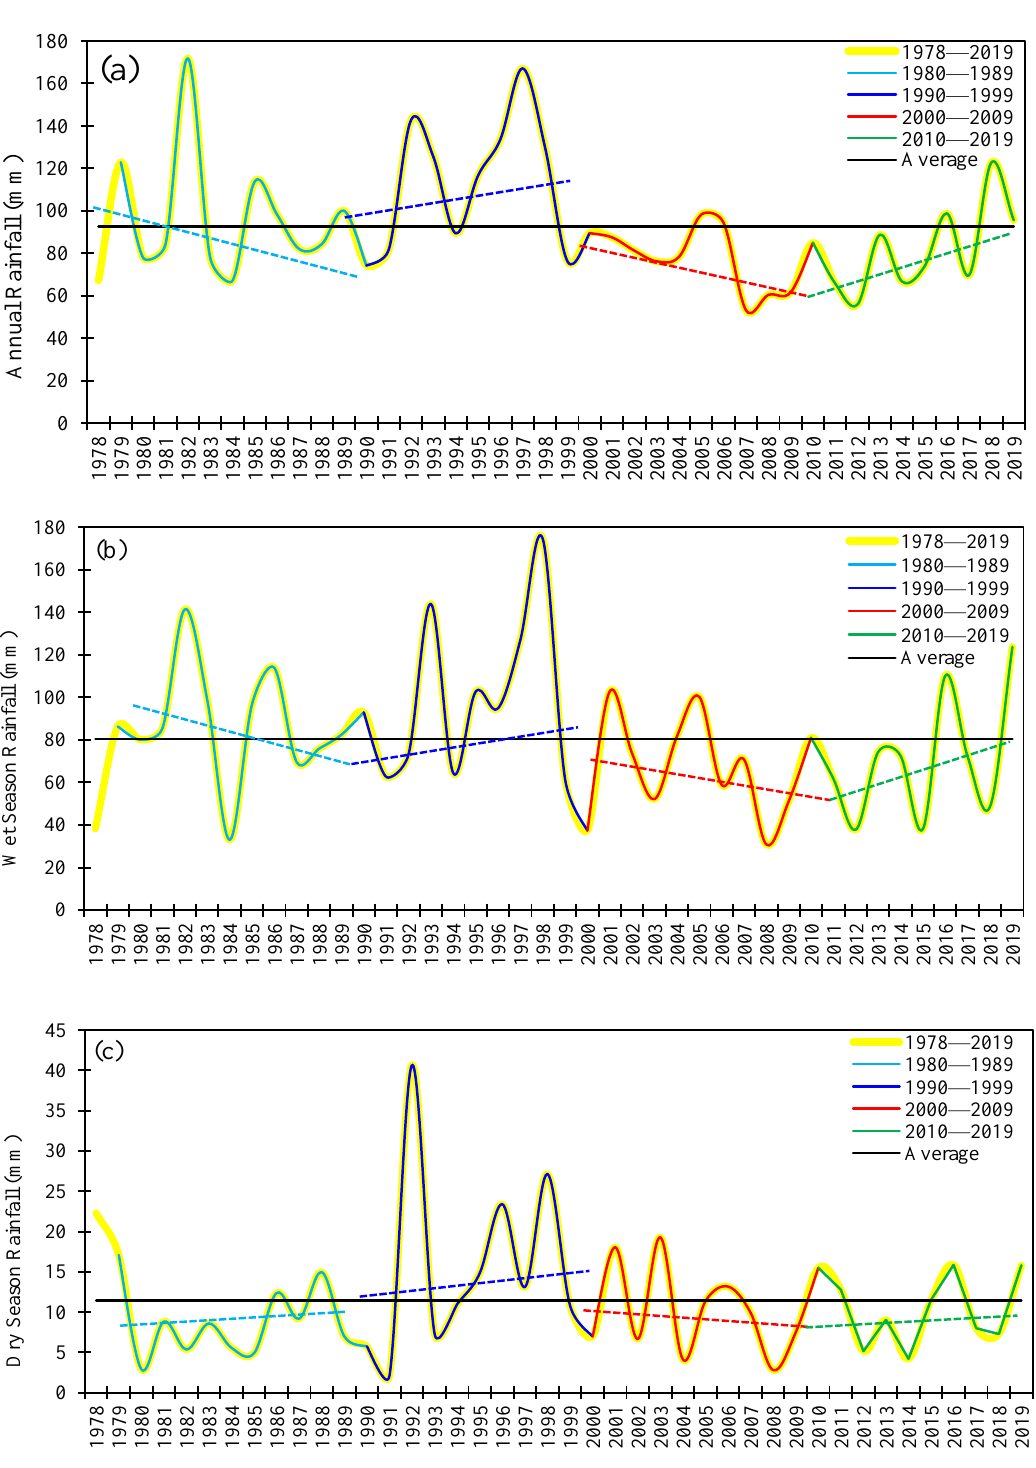
Figure 3. Time sequence of the country-averaged rainfall (mm) for ( a ) the whole year, ( b ) wet season, and ( c ) dry season for the period 1978–2019. The decadal trends are also shown at each panel for 1980–1989, 1990–1999, 2000–2009, and 2010–2019. The horizontal line indicates the average rainfall (mm): 92.54 mm for the whole year, 80.47 mm for the wet season, and 11.44 mm for the dry season. Note that the vertical scales are not the same for all the panels.